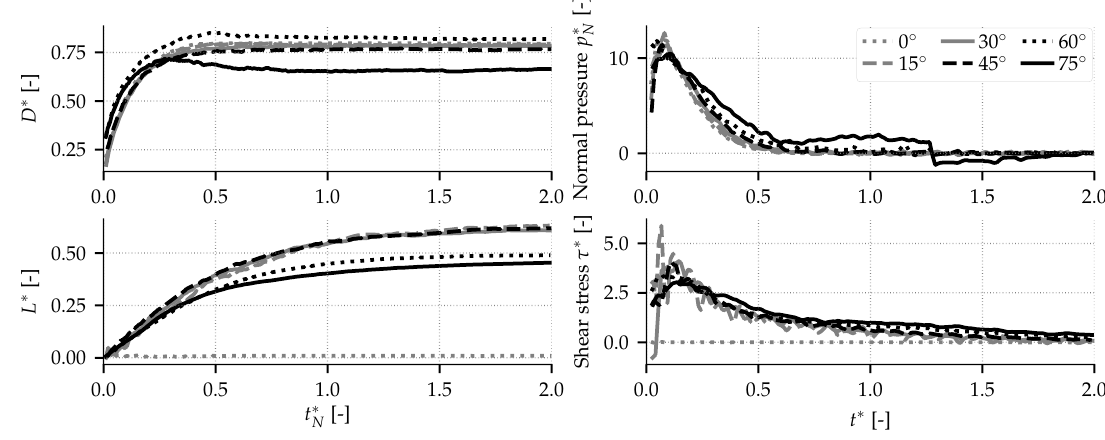
Figure 13. Influence of the impact angle on the transients of a sphere. Figure 14 depicts the transients of an oblique impact of a cube face at different impact angles.